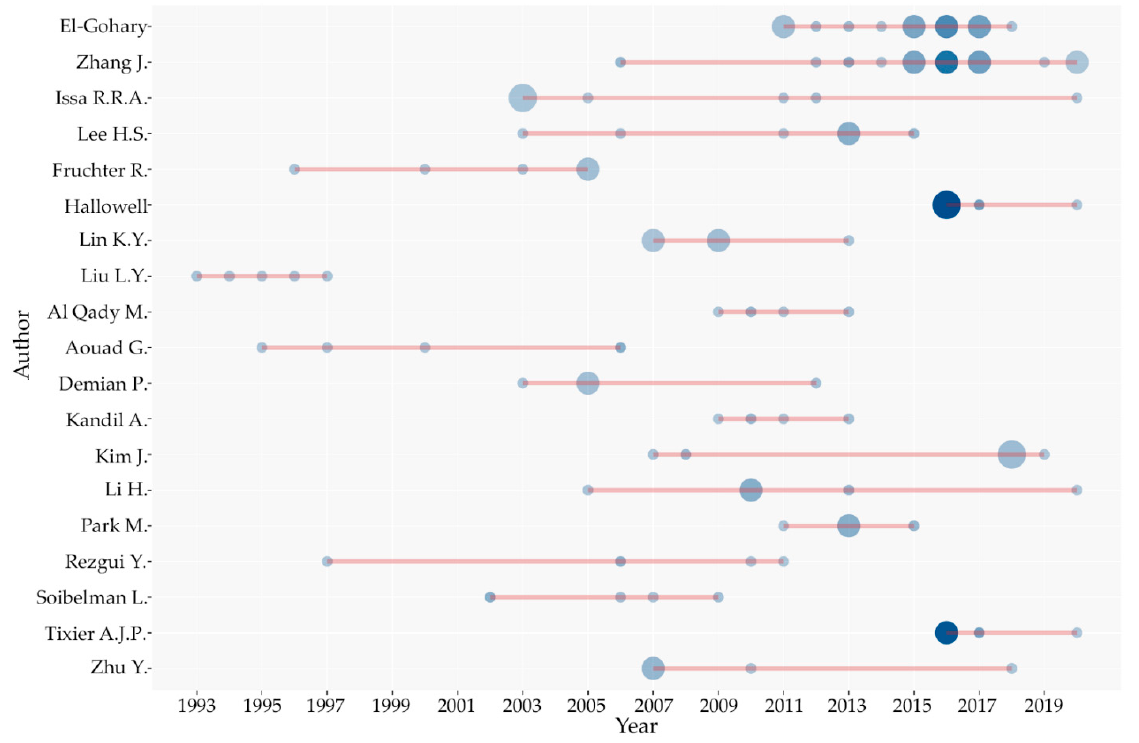
Figure 17. Top 19 author’s scientific production map (1993–2020). Software: BiblioShiny version 3.0.